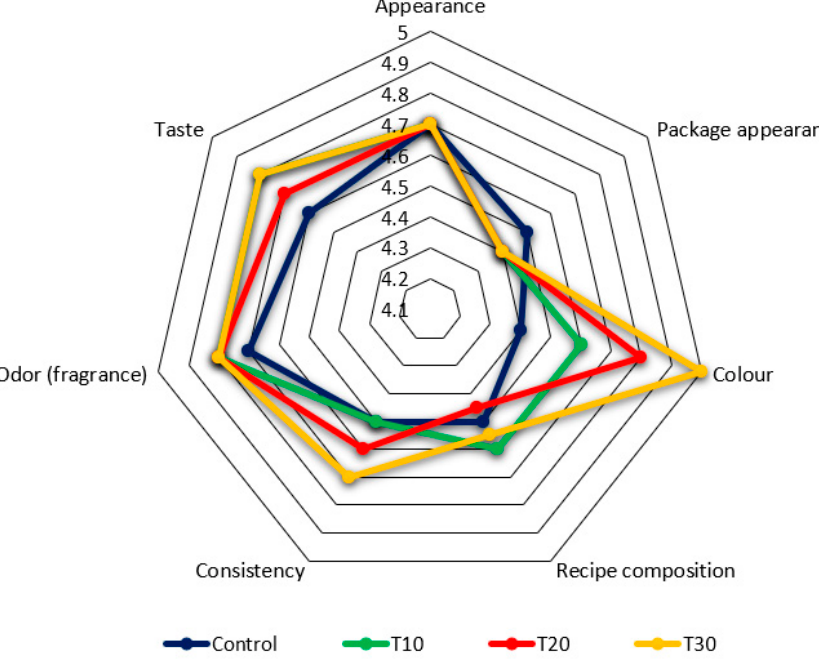
Figure 4. Organoleptic characteristics of the control and experimental samples of canned meat